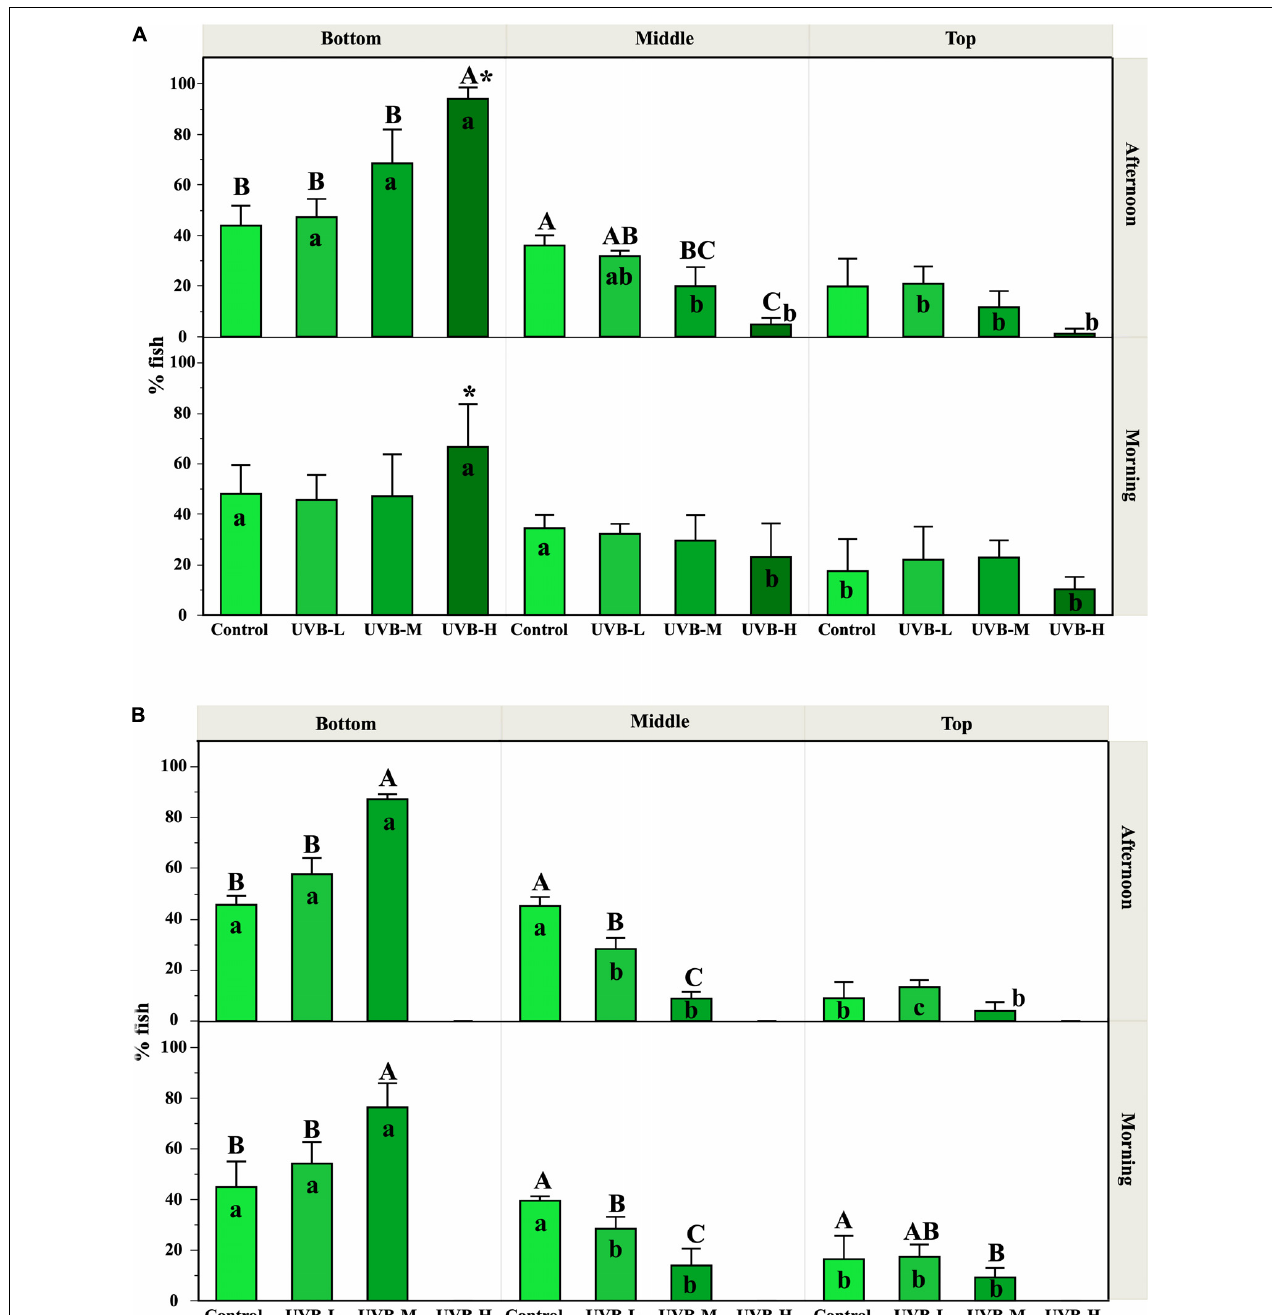
FIGURE 1 | Effect of UVB on the S. aurata swimming behavior observed along the experimental time. The fish position inside the tanks was recorded in the morning (1 h after starting UVB exposure) and in the afternoon (after 5–6 h under UVB exposure). The percentages of fish observed (mean ± SEM) at the top, middle, and bottom positions inside the tanks represent the mean from all the observations recorded during the first 8–16 days (A) and 26–40 days (B) , for each treatment and replicates. Significant differences between treatments within each tank zone and exposure period are represented by upper case letters ( P < 0.05; three-way ANOVA). For each treatment (within each exposure period), significant differences between tank zones are represented by lower case letters ( P < 0.05; three-way ANOVA). Within the treatment, * indicates significant differences between morning and afternoon ( P < 0.05; three-way ANOVA). Supplementary Figure S2 shows the percentage of fish observed in each tank zone on each day where behavior was recorded. In general, UVB doses in the middle and bottom tank zones were reduced by about 34–40% and 62–72%, respectively, compared to UVB in the top tank zone.